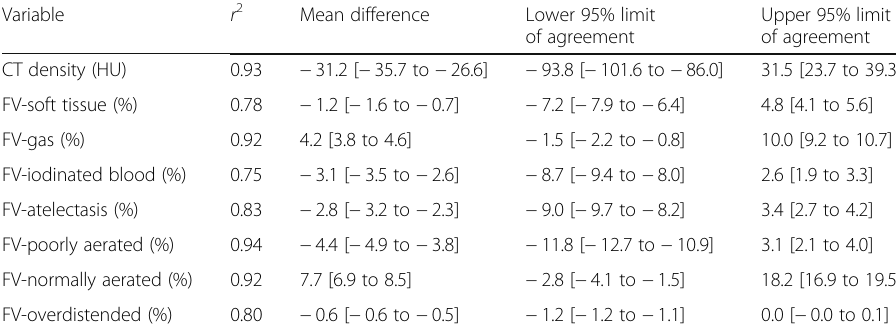
Table 2 Comparison of means of dCT and single-slice variables Variable r 2 Mean difference Lower 95% limit